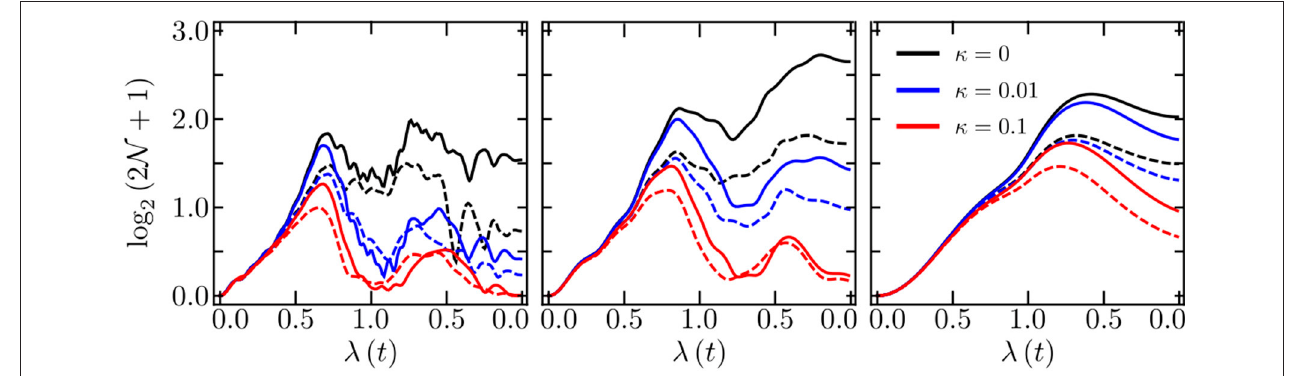
FIGURE 4 | We show evidence of the robustness of the many-body electronic-vibrational entanglement, as witnessed by quantum logarithmic negativity, to decoherence/losses. Results are shown for three representative, intermediate duration up-and-down pulses [i.e., the annealing velocities υ for left, middle, right panels 4.64, 3.32, 1.32 respectively]. Results are shown for N are log 2 (υ) = − − −